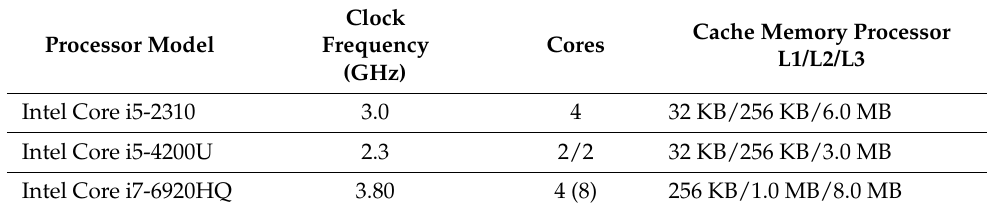
Table 2. Characteristics of applying Intel processors. Processor